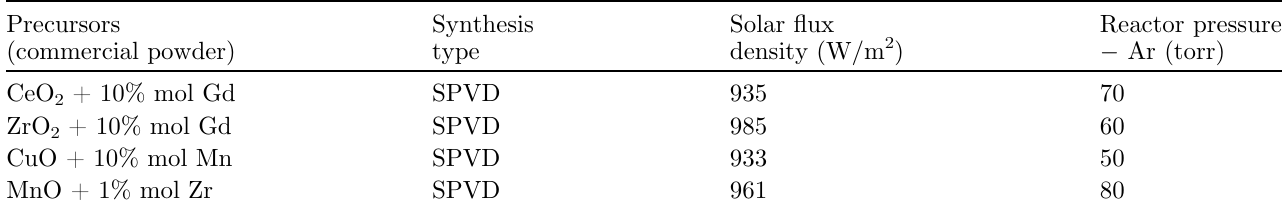
Table 1. Parameters of elaboration process by SPVD.